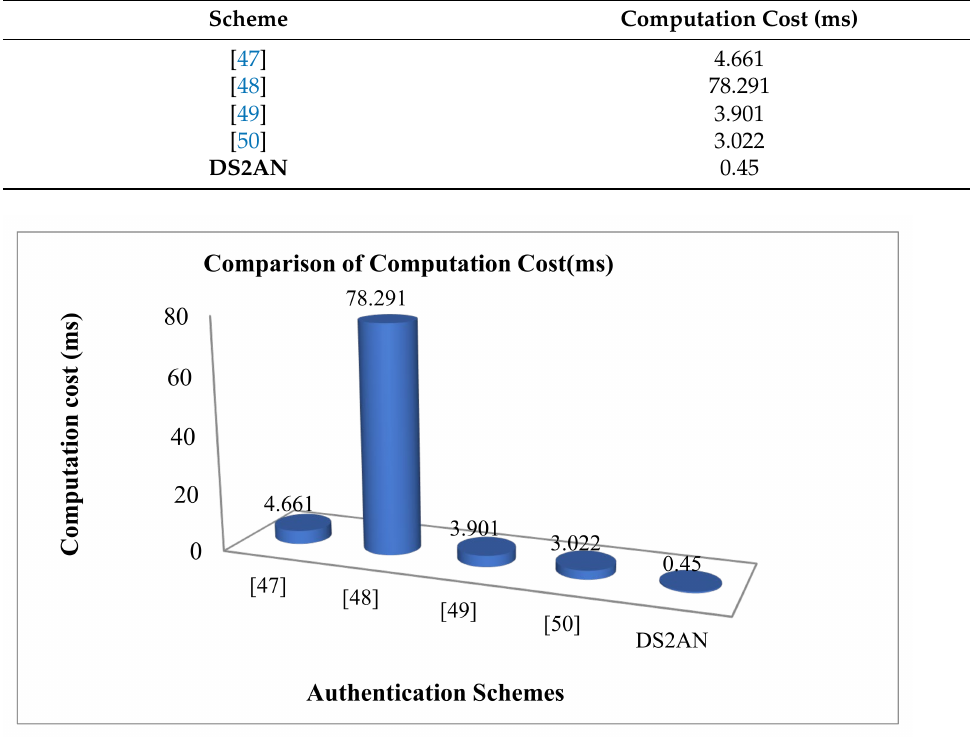
Figure 13. Computational Cost